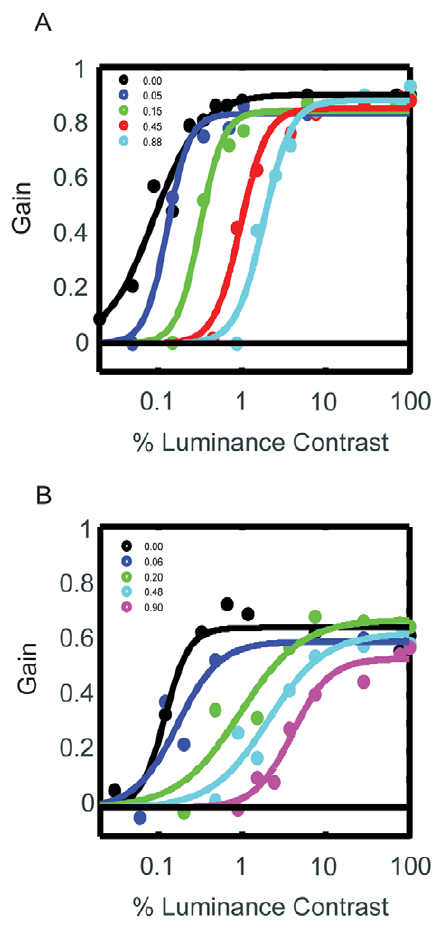
Figure 4. Effect of Opposing Contrast on COGF. Oculomotor gain is plotted as a function of contrast of the primary pattern. The contrast of the opposing pattern is depicted by each of the colors. Black represents no opposing pattern, i.e., when the contrast of that pattern was 0% RMS-contrast. A. This panel depicts the effect of the opposing pattern’s contrast, in Monkey A. As the contrast of the opposing pattern increased, the COGF shifted further to the right. B. The same change with increasing contrasts of the opposing pattern held in Monkey B.